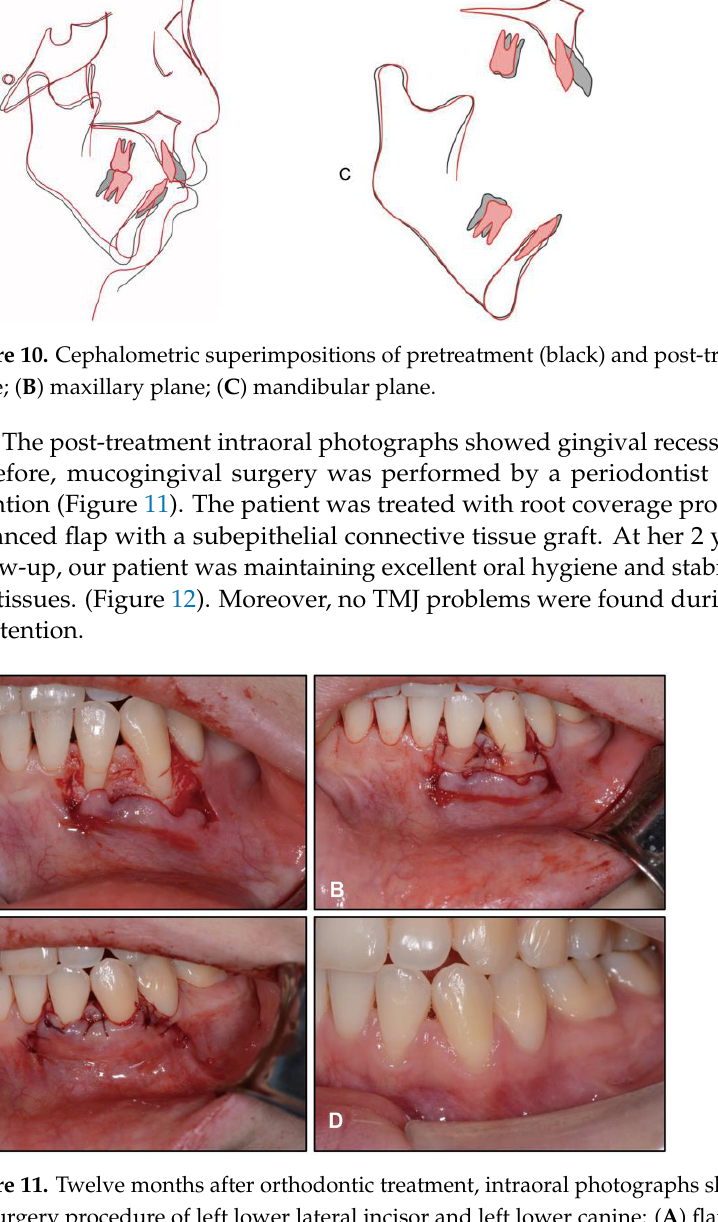
Figure 11. Twelve months after orthodontic treatment, intraoral photographs showed the mucogingival surgery procedure of left lower lateral incisor and left lower canine: ( A ) flap detachment beyond the mucogingival junction; ( B ) tissue graft fixed with resorbable sutures; ( C ) the flap fixed with sling sutures at the papillae; ( D ) two months after surgery.